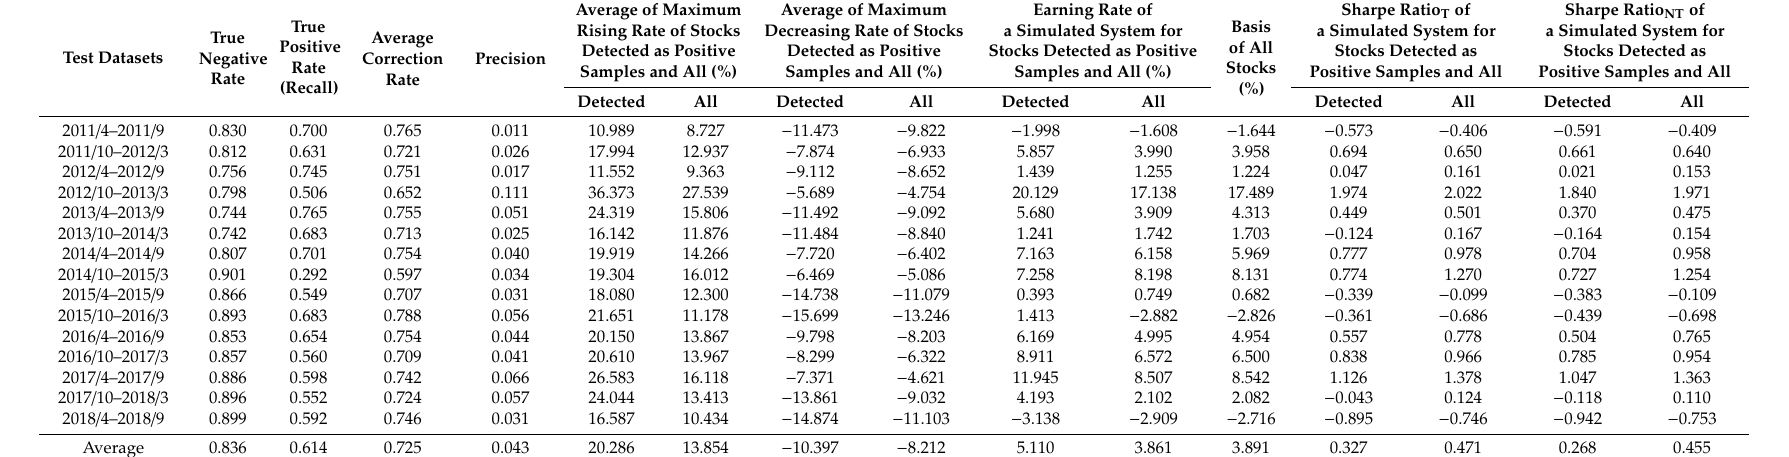
Table 4. Constant threshold-based stock classification with threshold 70%, W Loss (1:1), all features.